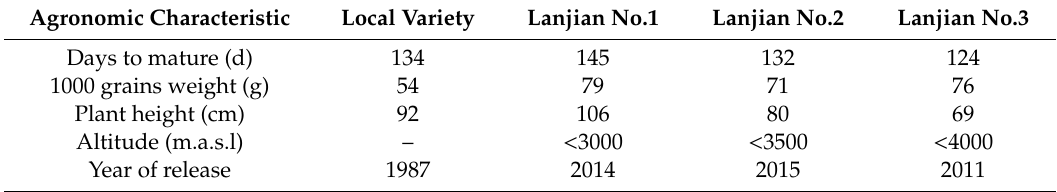
Table 2. Agronomic characteristics of the common vetch varieties used in this experiment. Agronomic Characteristic Local Variety Lanjian No.1 Lanjian No.2 Lanjian No.3 Days to mature (d) 134 145 132 124 1000 grains weight (g) 54 79 Plant height (cm) 92 Altitude